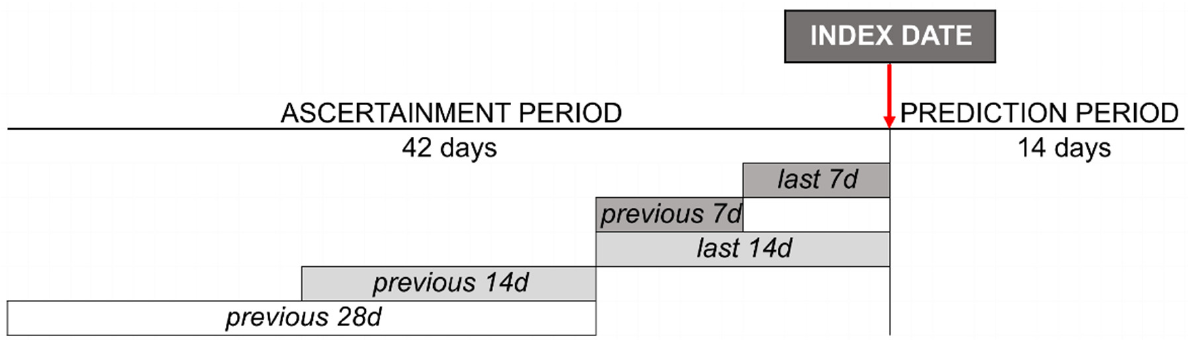
Figure 1. Study design: Reference timeframe for data collection/calculation is shown. For illustrative purposes, we established 3 risk categories: (1) low (L), when outbreak risk is less than or equal to 1.5%; (2) medium (M), risk greater than 1.5% and less than or equal to 12.5%; (3) high (H), if risk is greater than 12.5%. For this purpose, the action